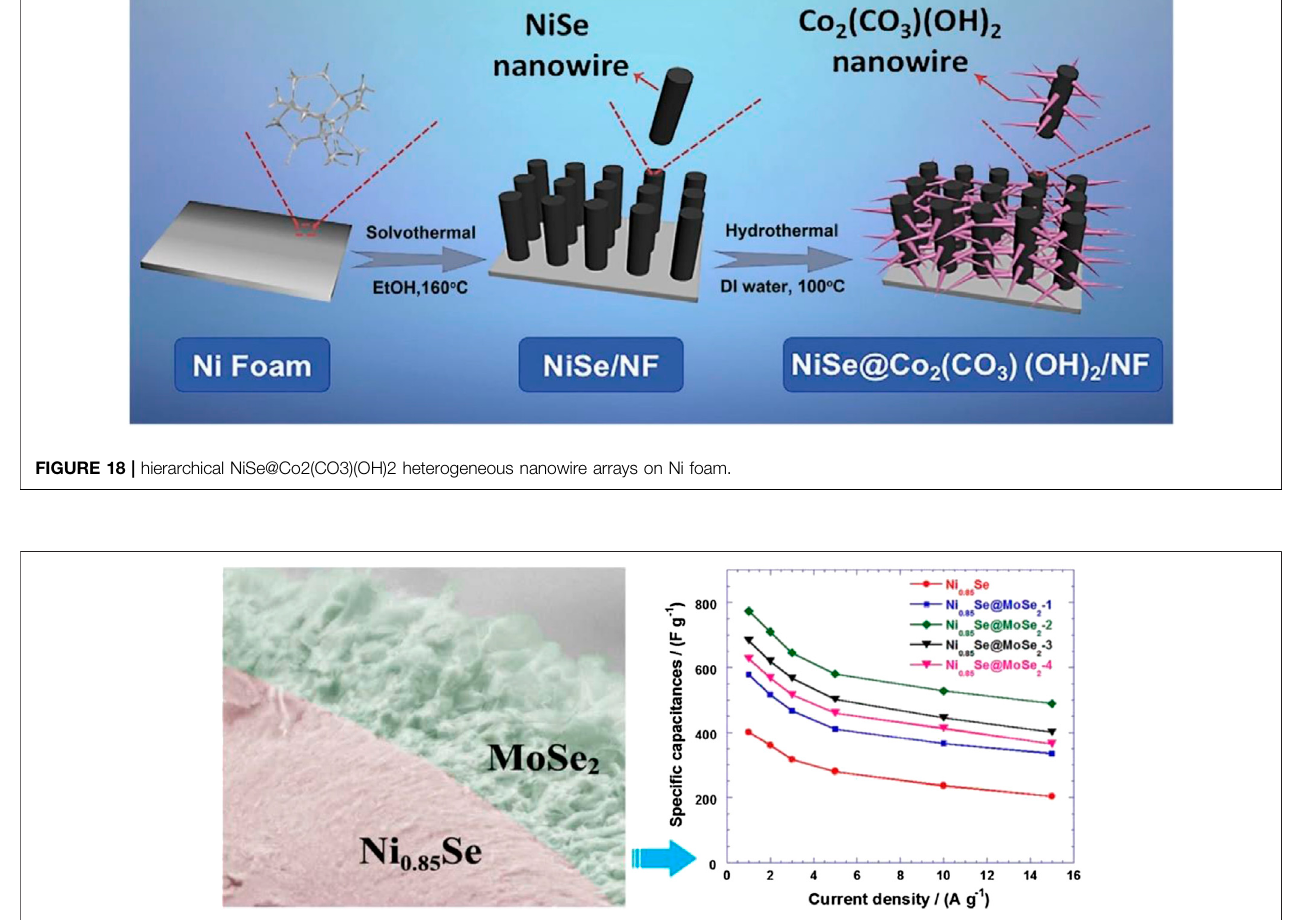
FIGURE 19 | Ni 0.85 Se@MoSe 2 nanosheet arrays as the electrode for high-performance supercapacitors.